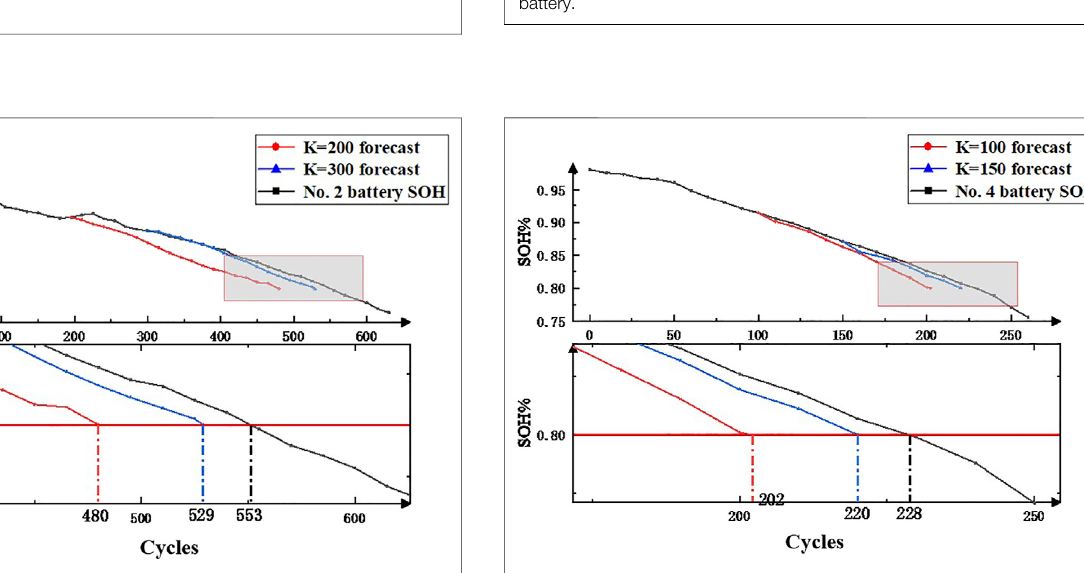
FIGURE 5 | Prediction results of the particle fi lter algorithm for No. 4